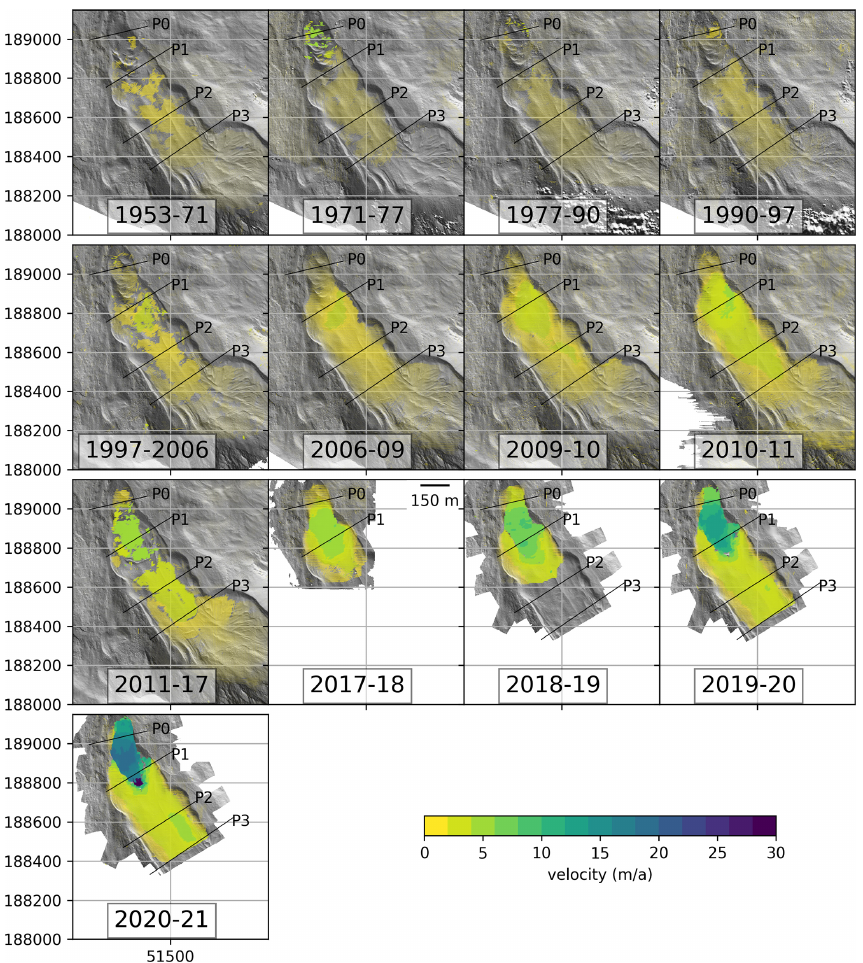
Figure 6. Velocity vectors (ma − 1 ) for the time series of DSM pairs, plotted over hillshades of the later DSM of each pair. Reference lines defining block profiles P0–P3 have been added for orientation purposes (coordinate grid: